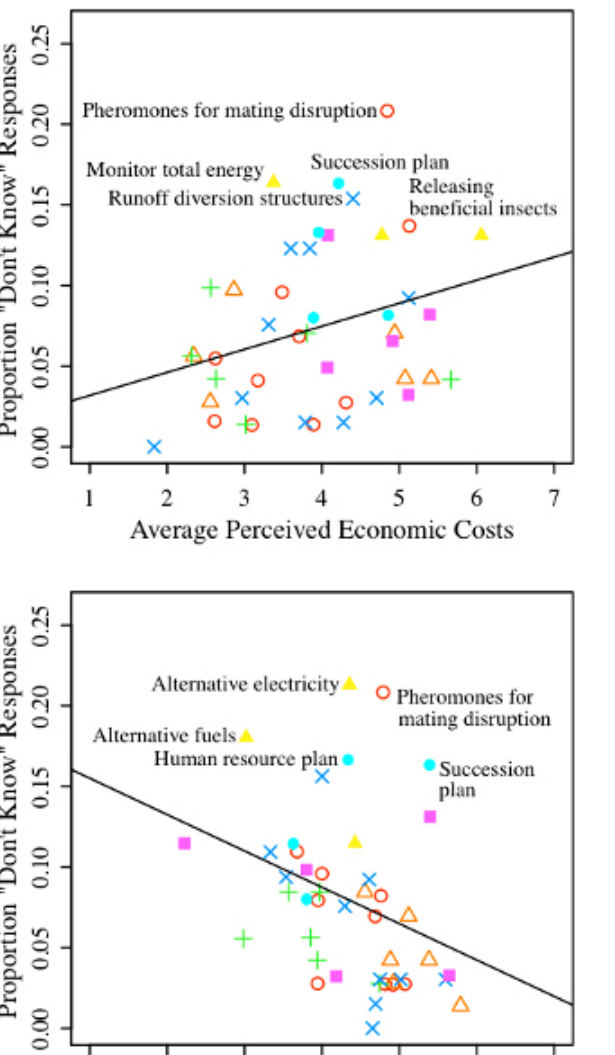
Fig. 5. Knowledge gaps as a function of practice benefits and